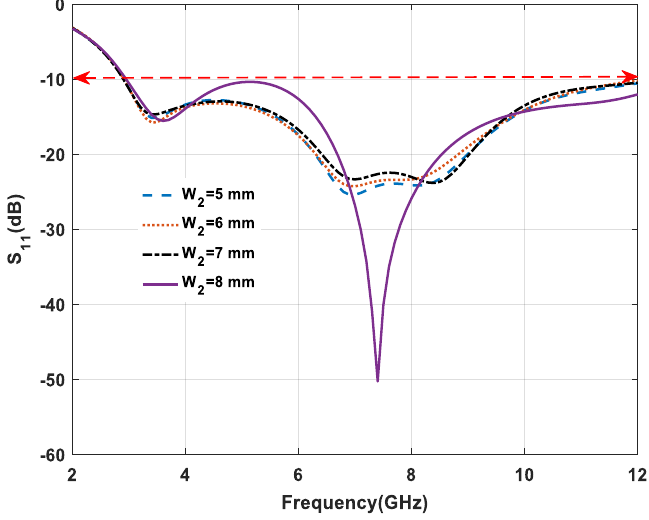
Figure 7. E ff ect of variation on W Figure 7. Effect of variation on W 2. Figure 7. Effect of variation on W 2.